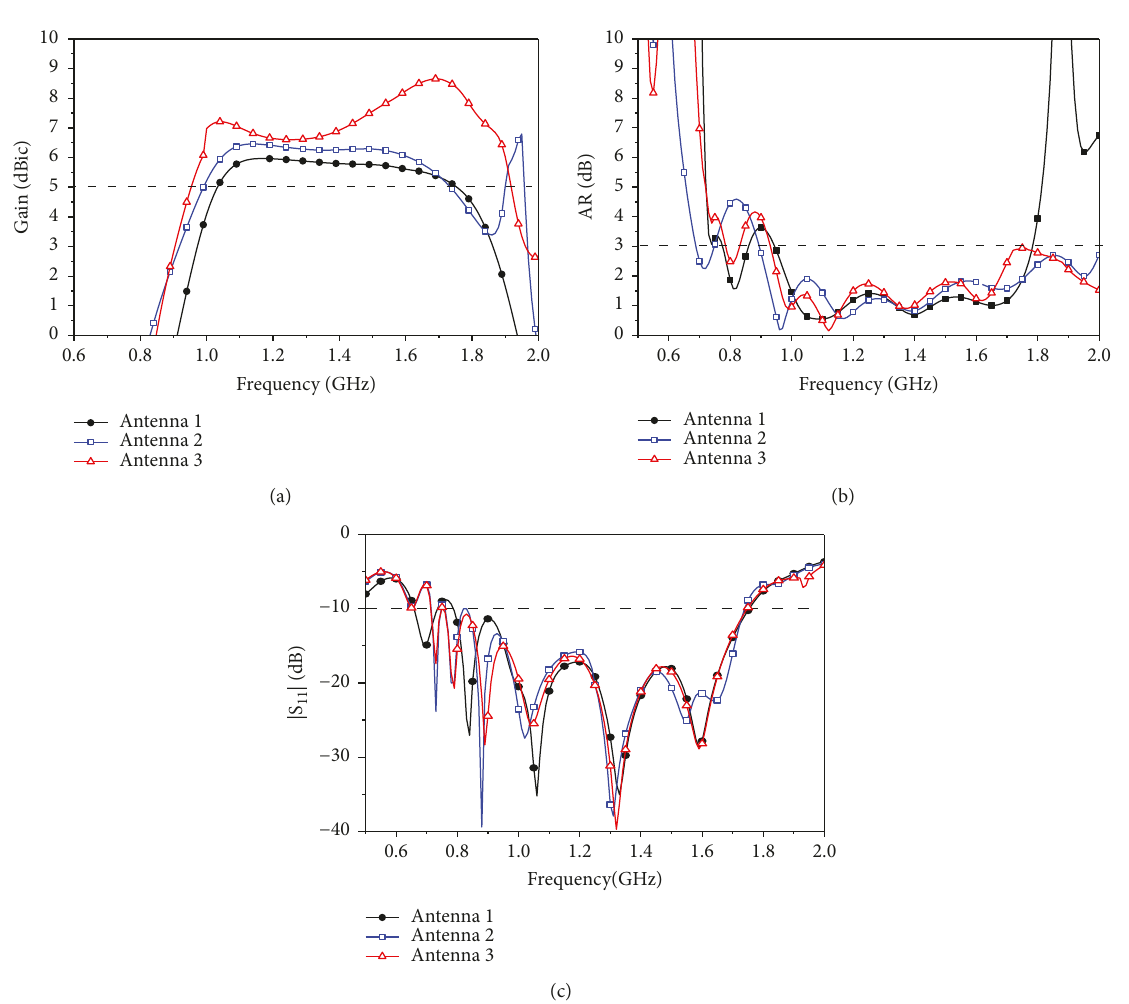
s for three type of antennas. 11